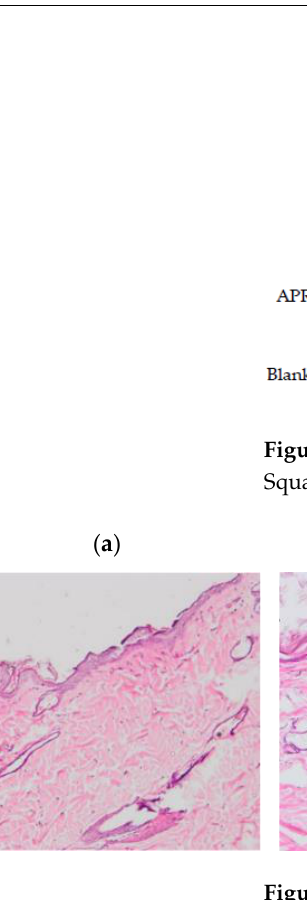
Figure 7. Histological sections of the dorsal area of rats (100 × magnification). Arrows indicate signs of tissue damage. ( a ) Basal, ( b ) Xylol (C+), ( c ) APR-Squalene, ( d ) Blank-Squalene.